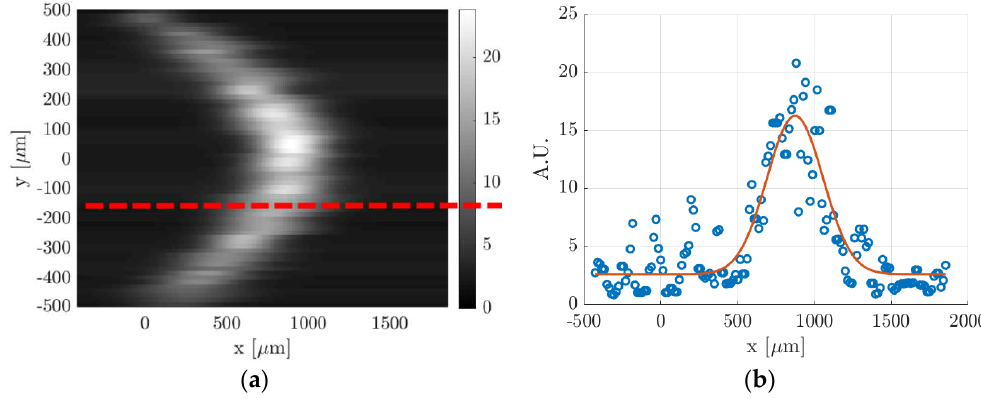
Figure 11. ( a ) Image resulting from the application of the Gaussian fitting per line to a raw MTV image and ( b ) example of data distribution along a horizontal line of pixels, indicated by the red dashed line in ( a ), and the corresponding Gaussian fitting (A.U. stands for arbitrary